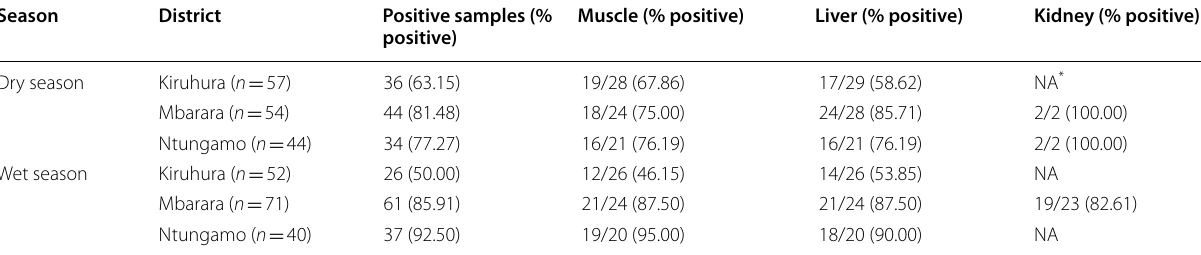
155) and wet season ( n 143) = =